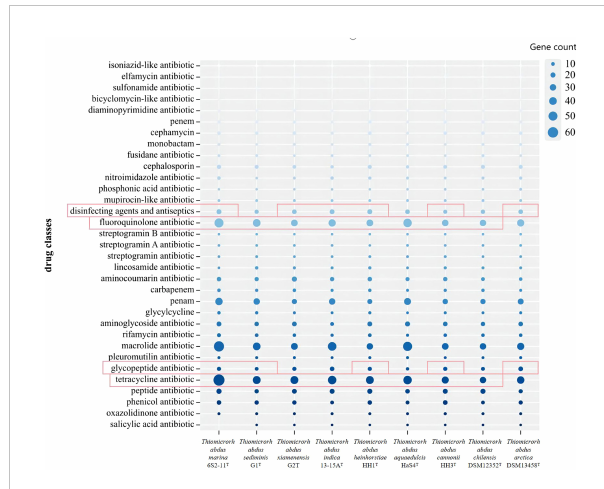
FIGURE 6 The gene count of different antibiotics resistance genes annotated for Thiomicrorhabdus strains. Red highlighting indicates that it has genes that are annotated by a rigorous